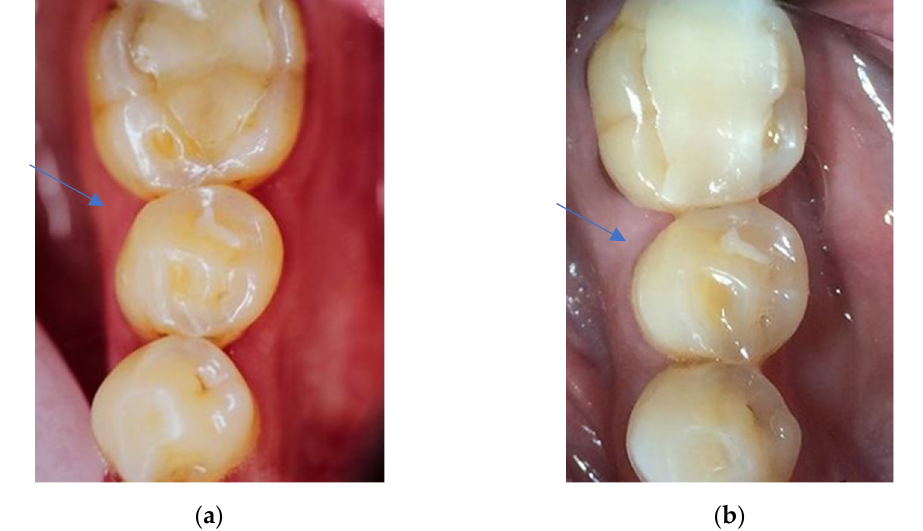
Figure 7. ( a ) Clinical view of a Herculite XRV restoration at first examination (35 od). Aesthetic anatomical form, marginal adaptation, tooth integrity, retention, and surface luster were examined with grade 1 (clinically excellent/very good). Occlusal contour/wear scored grade 2 (clinically good) at the first examination. Approximal anatomical form scored the highest grade of all criteria at first examination: grade 4 = clinically unsatisfactory. ( b ) Clinical view of the Herculite XRV restoration displayed in Figure 7a after 24 years in situ. Only one criterion, approximal anatomical form, scored a lower grade at the second evaluation (grade 3 = clinically sufficient/satisfactory) than at the first evaluation. This was the case because the restoration of the neighbor tooth was replaced, and thus a new, clinically sufficient approximal contact point was created. Occlusal contour/wear were evaluated as having the same score (grade 2) at the second and at the first follow-up evaluation. The criteria aesthetic anatomical form, marginal adaptation, tooth integrity, retention, and surface luster were all evaluated one grade higher at the second evaluation and therefore scored clinically good results (grade 2).